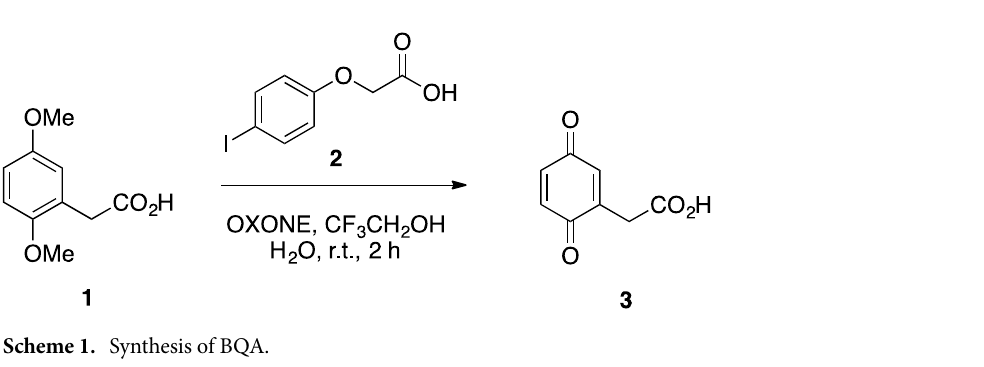
Scheme 1. Synthesis of